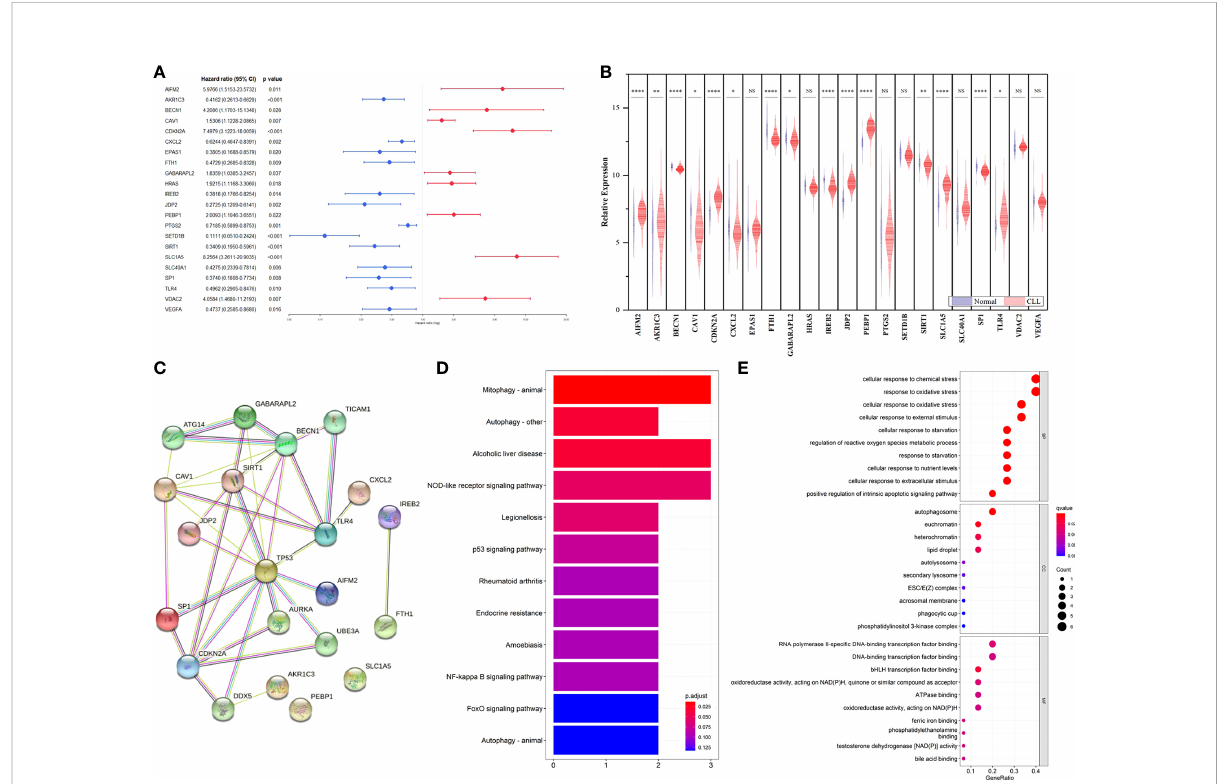
FIGURE 1 Identi fi cation of prognostic FRGs in CLL cohort. (A) Forest plot with hazard ratios of the univariate Cox regression analysis showing the FRGs with prognostic value in the GSE22762 dataset. (B) The differential expression of FRGs between CLL and normal samples in the GSE50006 dataset. (C) PPI network showing the interactions among the 15 FRGs. (D) KEGG analyses of the pathways enrichment of the CLL related FRGs. (E) GO analyses of the functional enrichment of the CLL related